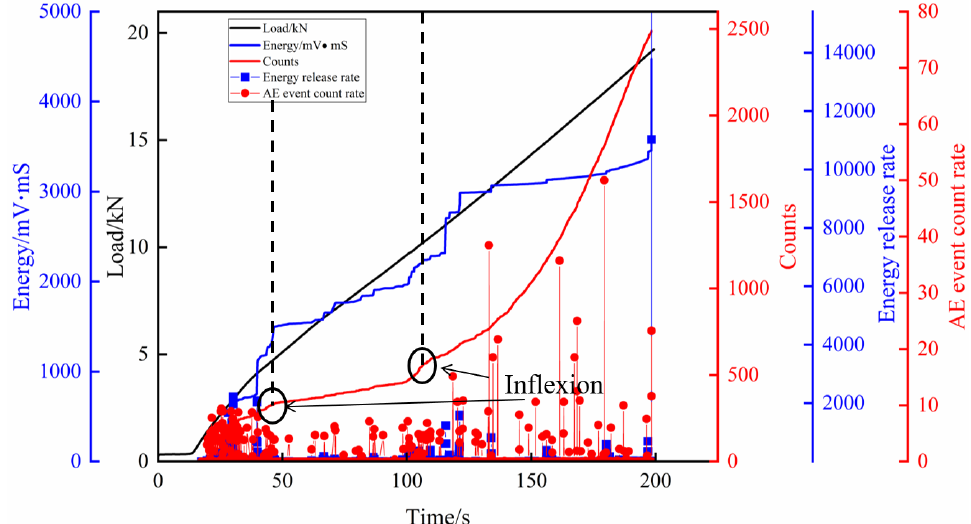
Figure 8. Tensile load, accumulative energy, counts, energy release rate, and AE event count rate vs. time for the composite specimen.